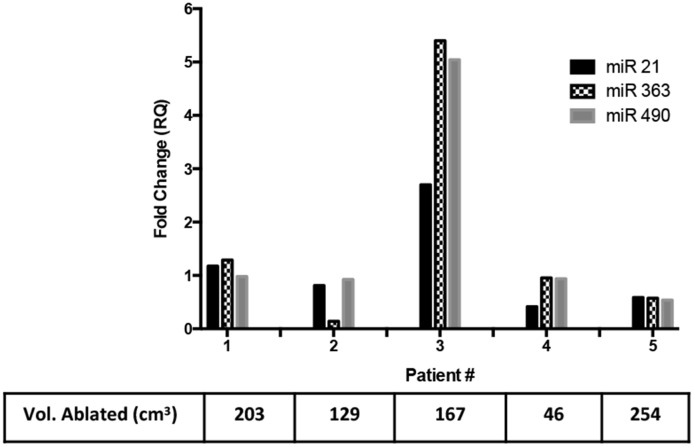
Release of miRNA-biomarkers from uterine fibroid patients.Five patients were tested for an increase in common miRNA found in uterine fibroids. Only one patient (#3) showed fold-increases in the post-treatment samples when compared to pre-treatment samples for miR-21 (2.7-fold), miR-363 (5.4-fold) and miR-490 (5.04-fold). There seemed to not be any correlation of the fold change to the volume of the uterine fibroid ablated (table corresponding to x-axis).